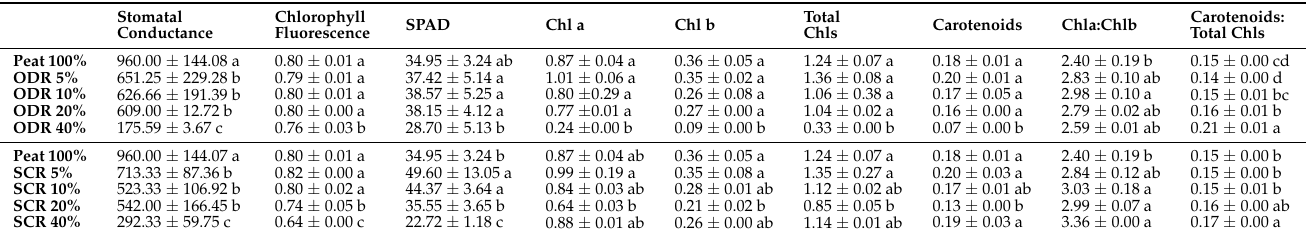
Table 4. Effects of the growing media (Peat, O. dubium residue—ODR, and S. cypria residue— SCR) on sowthistle chlorophyll fluorescence (Fv/Fm), stomatal conductance (s/cm), chlorophyll levels (Chl a, Chl b, total Chls; mg/g fw), and carotenoid (mg/g fw) content on plants grown in a